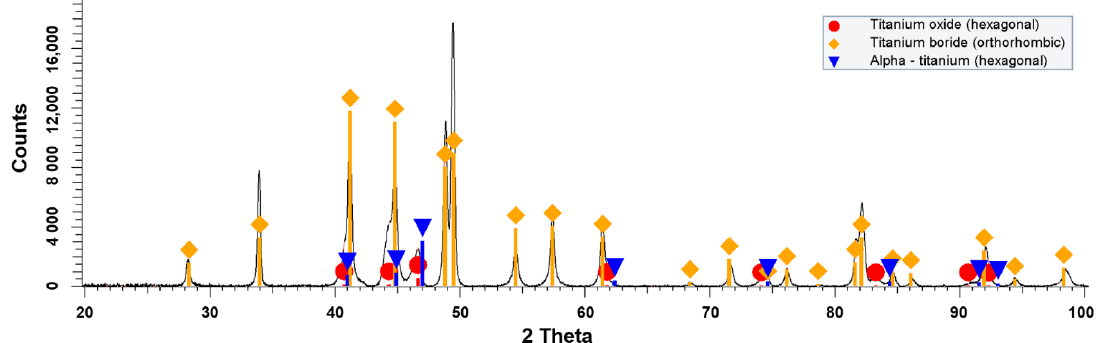
Figure 2. XRD pattern of the Group I specimen (Ti-TiB 2 , sintering parameters: 1250 ◦ C, 50 MPa, 15 min).